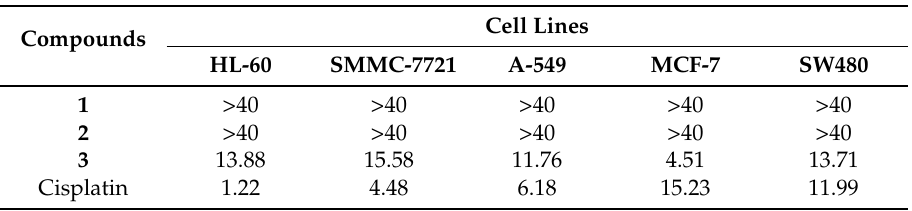
Table 2. Cytotoxic activities of compounds 1 – 3 with IC 50 values ( μ M).